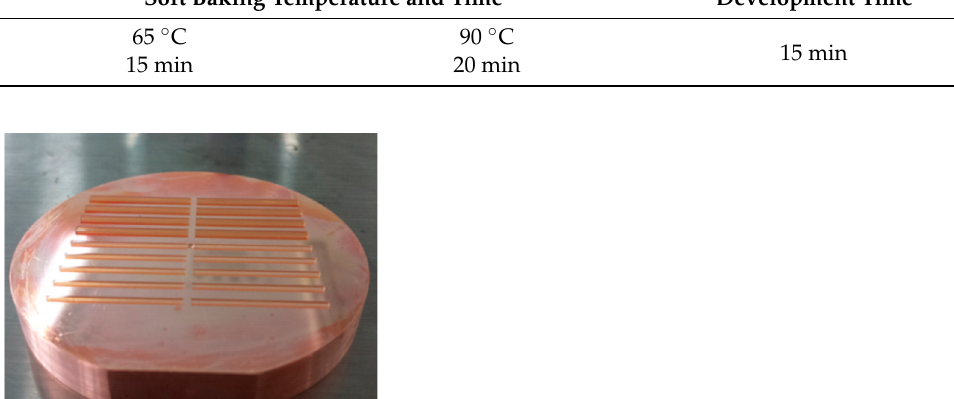
Table 3. Post-exposure baking parameters and development time. Table 3. Post ‐ exposure baking parameters and development time.